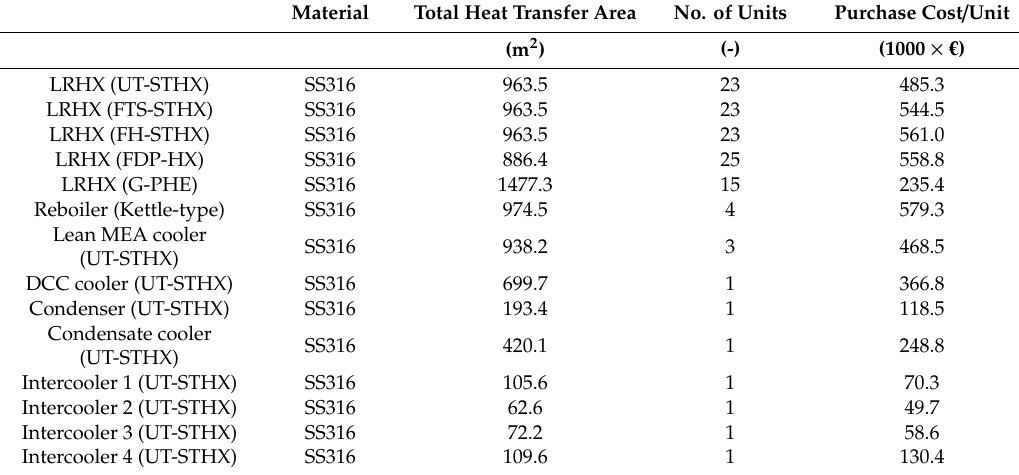
Table A4. Heat exchange equipment dimensions and purchase costs from Aspen In-Plant Cost Estimator V11 (purchased cost year: 2018).